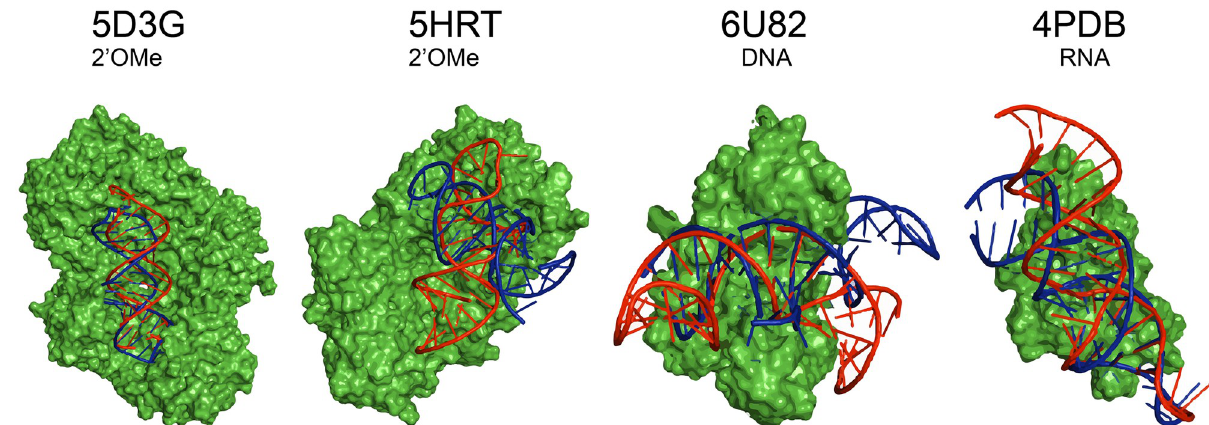
Fig 3. Comparison of the docking models deposited experimentally (in blue) in the PDBe database and the in silico docking models predicted through the described workflow (in red) for the 2´OMe (5D3G and 5HRT), DNA (5HRU) and RNA (6SY4) aptamers. The target molecules (in green) were isolated from the aptamer-target complexes determined experimentally using the PyMOL software and used as a receptor in the docking prediction.